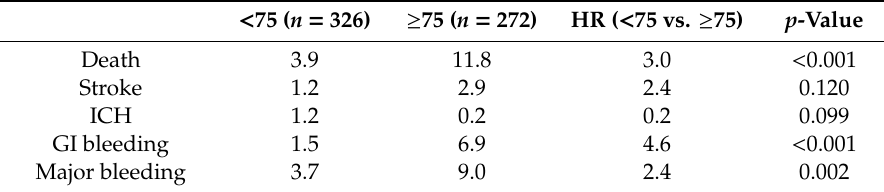
Table 2. Adjusted event rates per 100 patient-years.